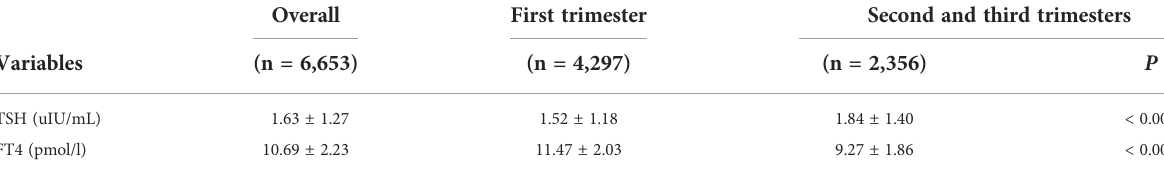
TABLE 2 The concentrations of maternal serum TSH and FT4 during different